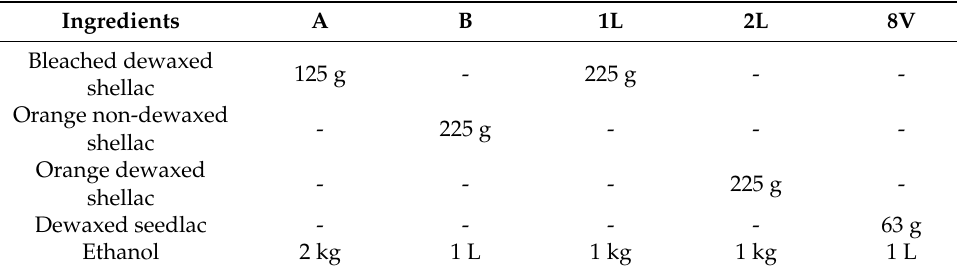
Table 2. Varnish recipes listed in Table